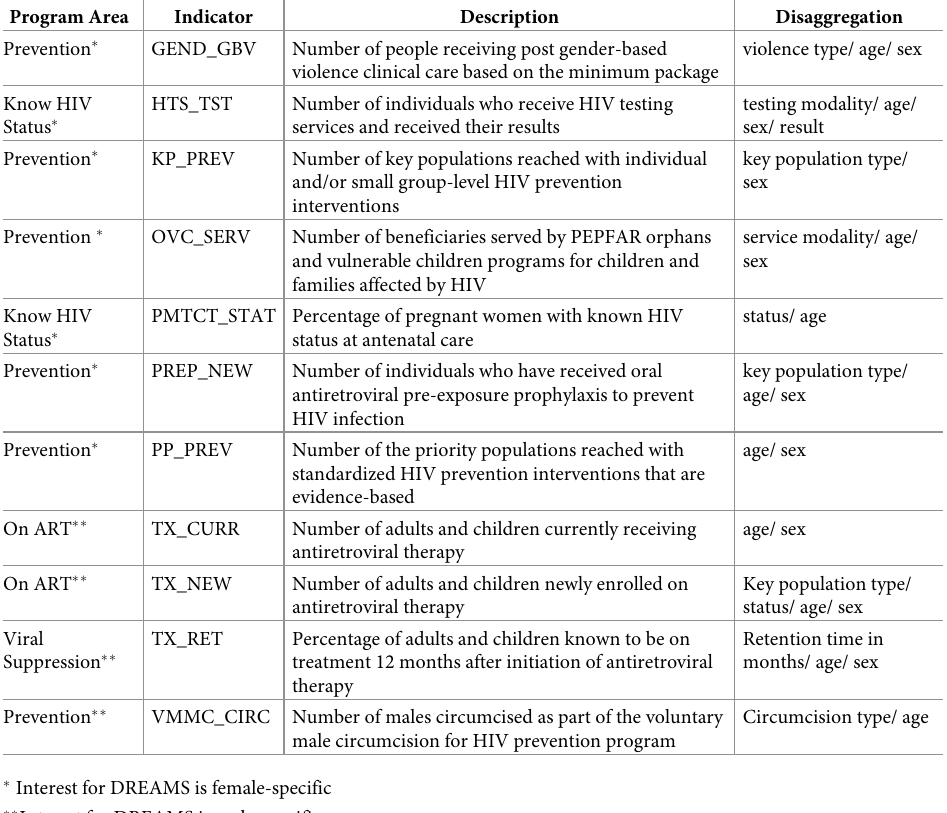
Table 2. PEPFAR program indicators monitored for